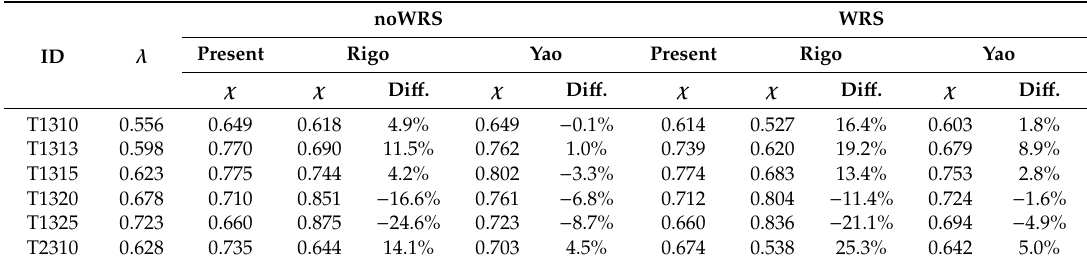
Table A3. Results obtained in the present study and in the ISSC’2000 benchmark calculations for the ultimate strength of tee-bar sti ff ened plates